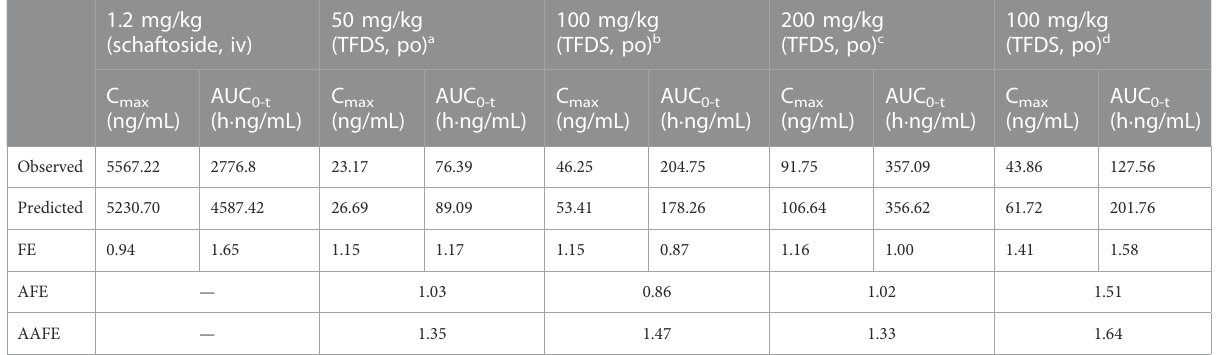
The predicted schaftoside plasma concentration-time pro fi les for these populations ( n = 100) are shown in Figure 8. The predicted C max and AUC 0-t values of schaftoside in the high-dose group (1 g) were 1.67 times higher than that in the regular-dose group (0.6 g) following single- and multiple- dose administration of TFDS in healthy population. Compared to the healthy subjects, the plasma exposure of schaftoside was higher in CKD patients. After the single dose of 0.6 g TFDS, the mean AUC 0-t values in CKD3, CKD4, CKD5 patients were 2.14, 3.47, 4.02-fold of the data in healthy population (0.6 g), but the maximum plasma concentration of schaftoside did not differ signi fi cantly in these populations (Table 6). After multiple-dose